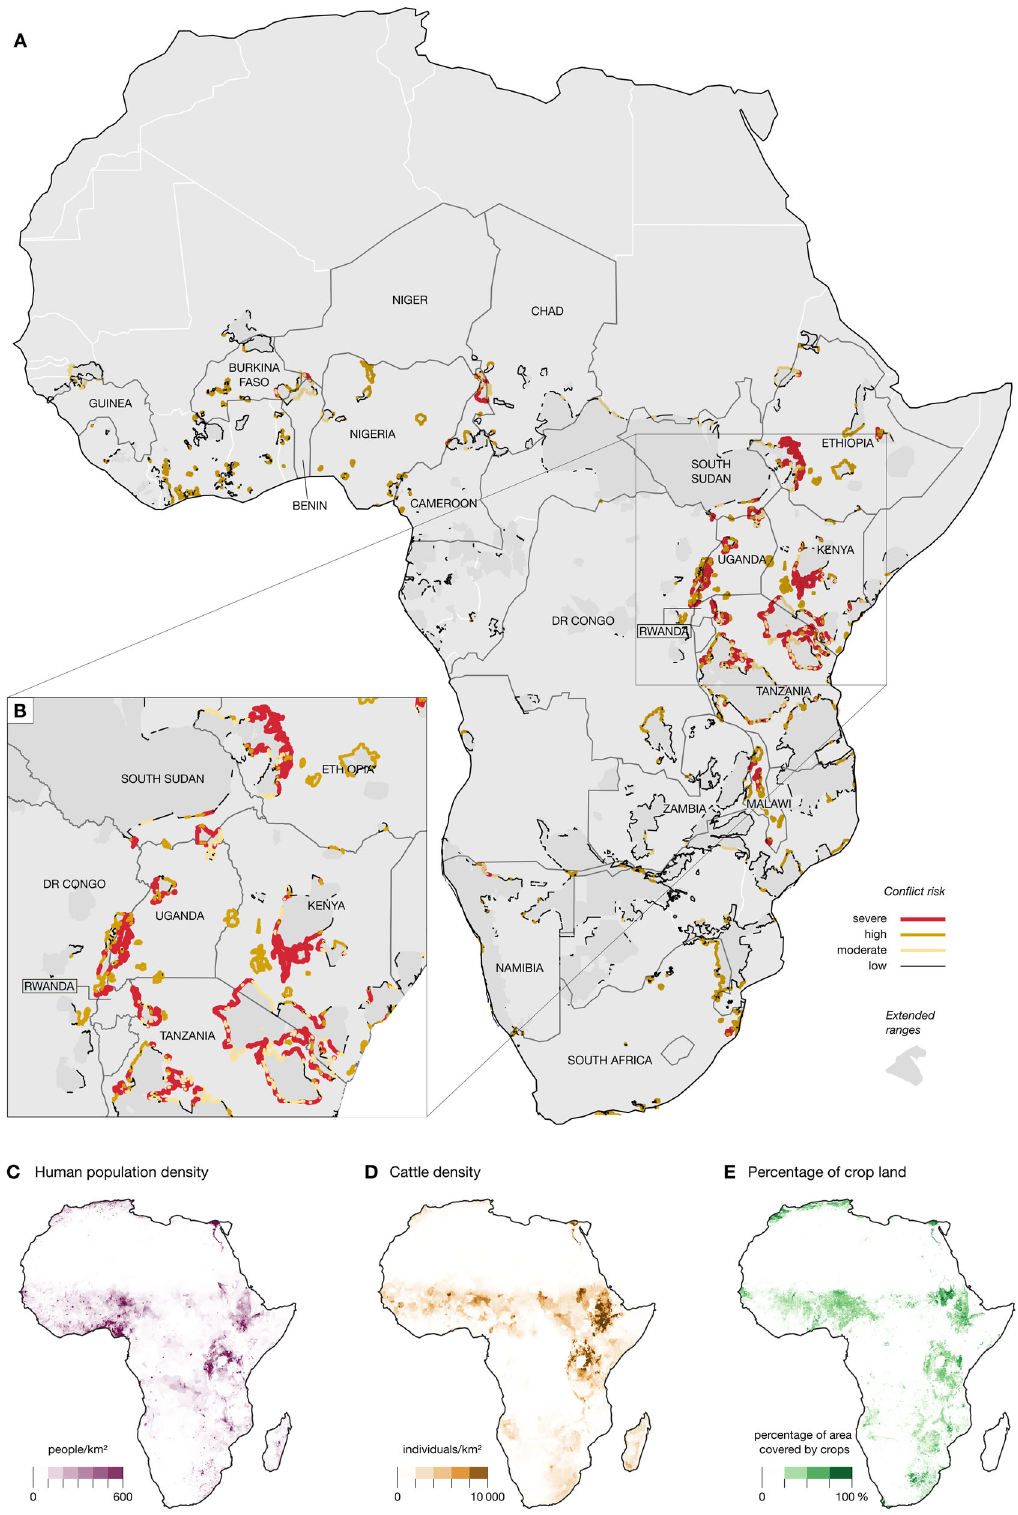
Fig. 2 Areas at risk of con fl ict on the extended ranges of African lions ( Panthera leo ) and African elephants ( Loxodonta africana and Loxodonta cyclotis ). A Areas at risk of con fl ict across all of Africa. Extended range of elephants and lions are in dark grey. De fi nitions of severe, high, moderate, and low risk of con fl ict are given in the legend to Table 1. B Areas at risk of con fl ict in East Africa. C Human population density, D cattle density, and E proportion of cropland maps. See handling of uncertainty over spatial mapping in Supplementary Figs. 5 and